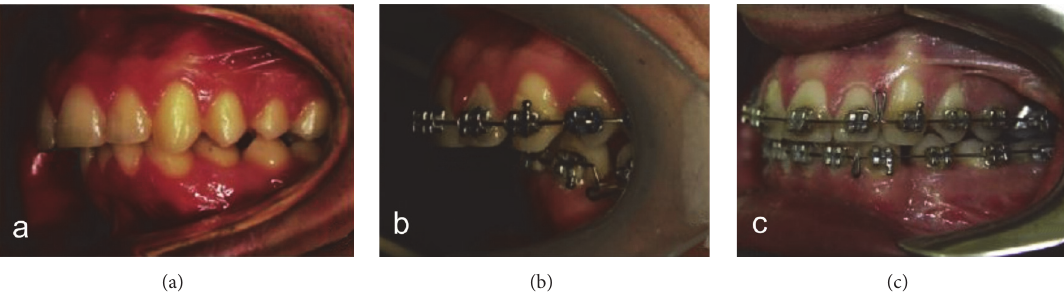
Figure 7: Lateral occlusion before orthodontic treatment (a), at the end of presurgical orthodontics (b), and after surgery (c).